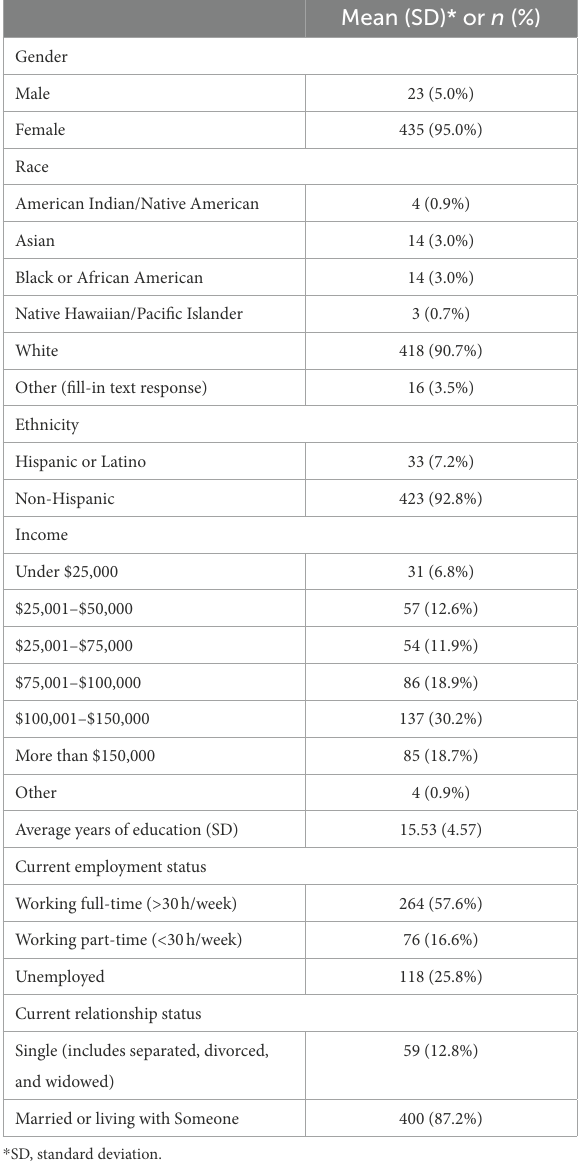
TABLE 2 Parent dyad demographic characteristics ( N =